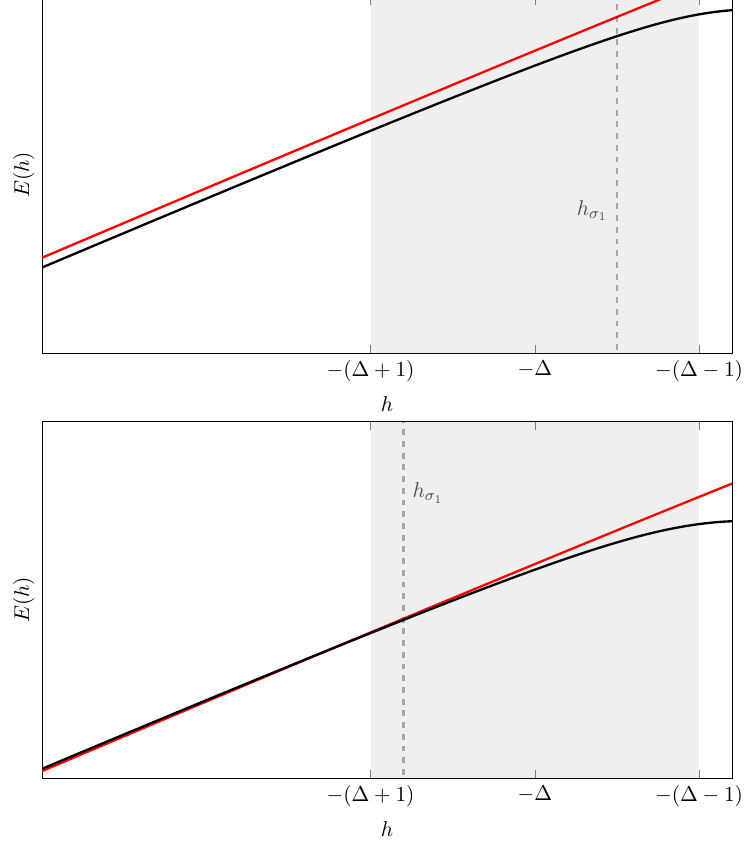
Figure 7: Energies of the lowest states obtained by exact diagonalization, for two values of h σ in the critical region ( − h ( 2 ) 1 In red: m = + 1. Notice that, as we pick h σ appears when h σ becomes small enough. Here ∆ = 3, L = 14 2